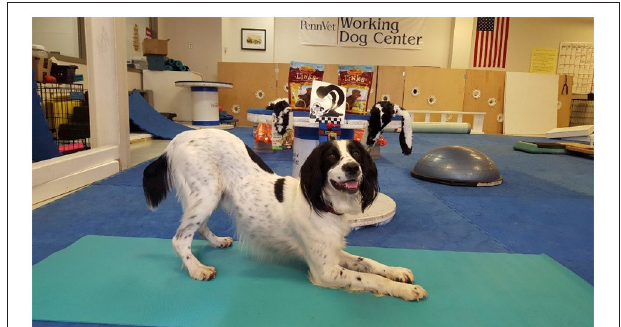
FIGURE 1 | Play bow stretch.